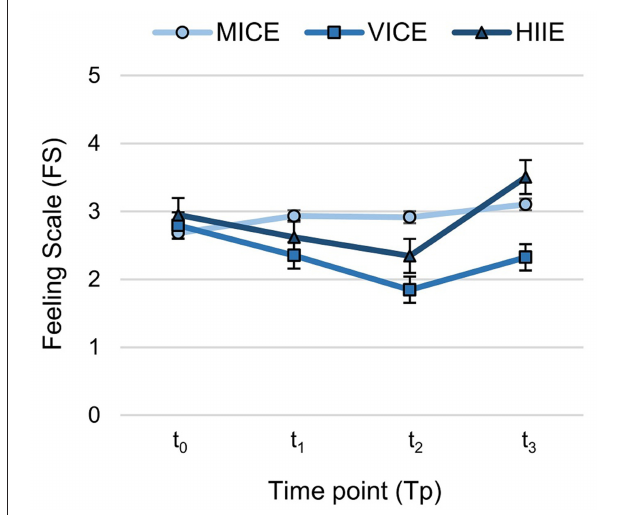
FIGURE 4 | Course of affective valence (Feeling Scale) across the session within the three different exercise modalities: MICE, moderate-intensity